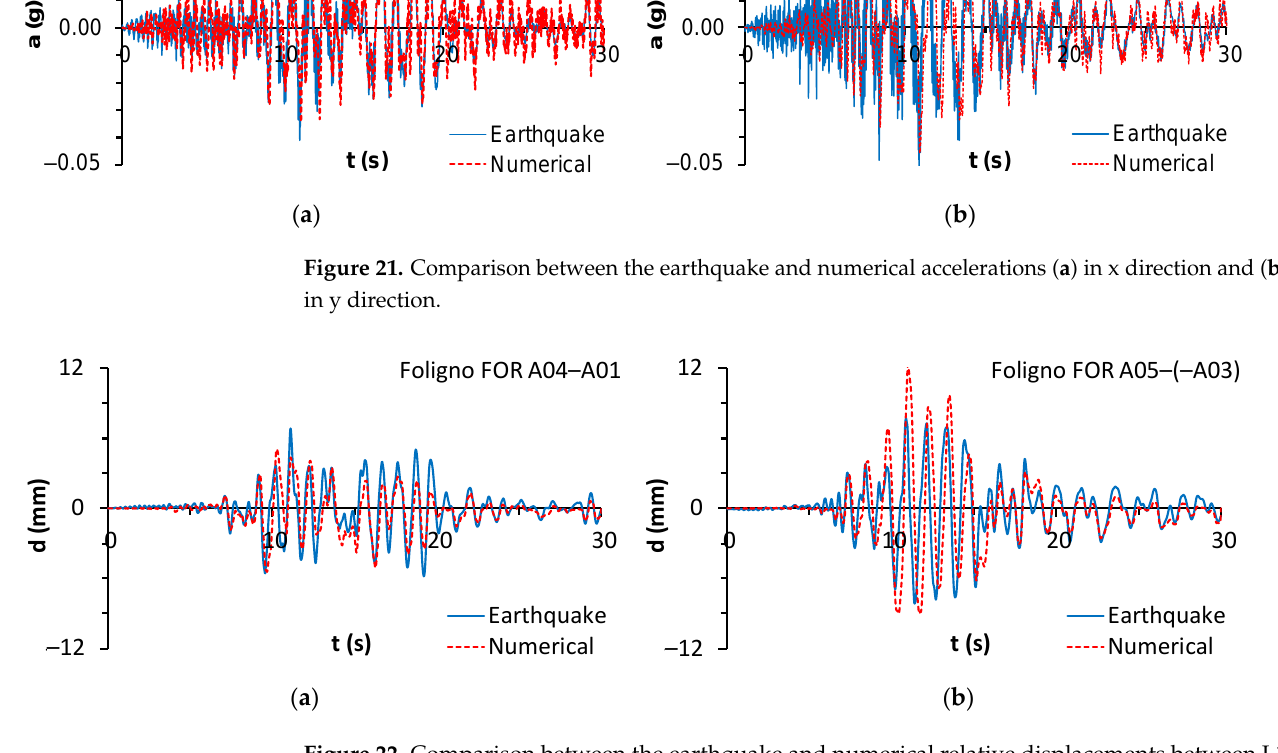
Figure 22. Comparison between the earthquake and numerical relative displacements between L1 and L0, ( a ) in x direction and ( b ) in y direction.